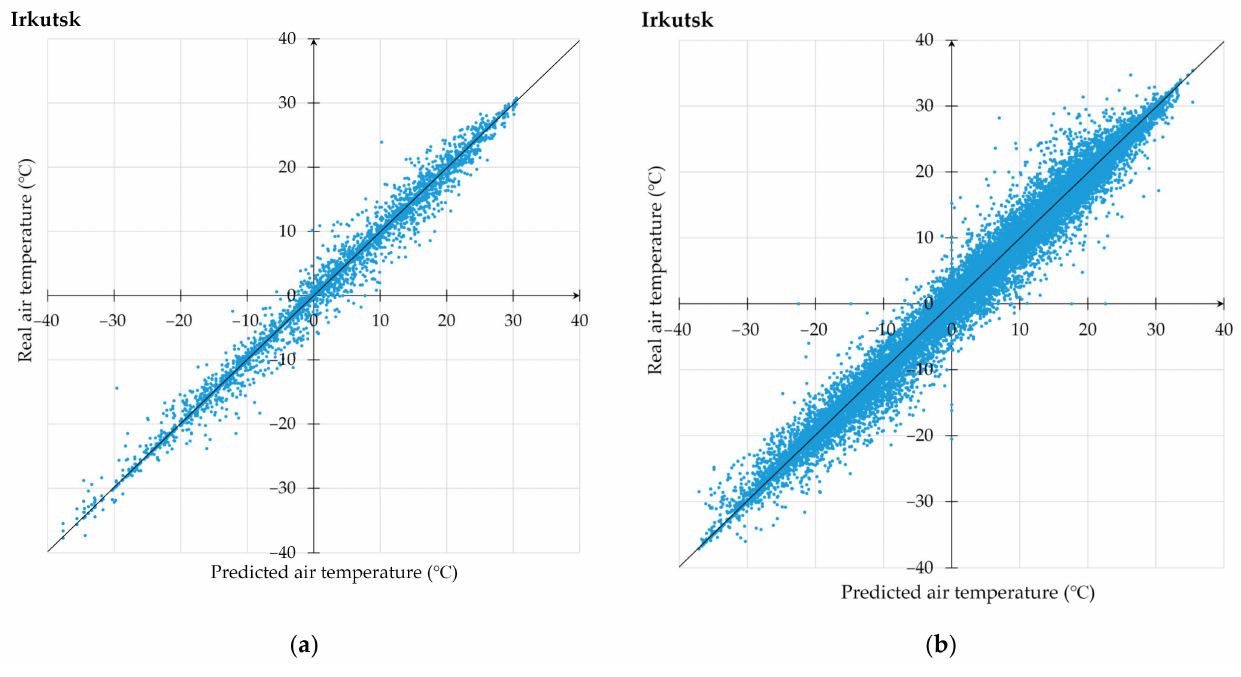
Figure 6. Prediction error scatter of (cid:101) x w for Irkutsk.